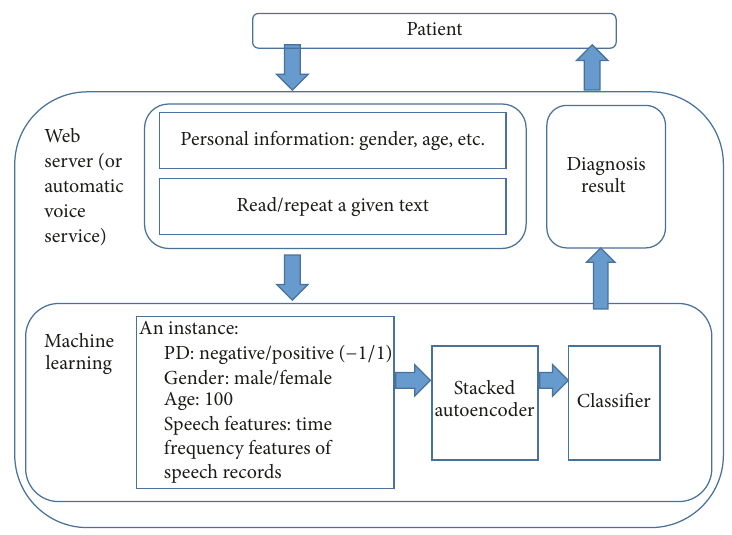
Figure 2: Acquisition and diagnosis of PD telediagnosis method.